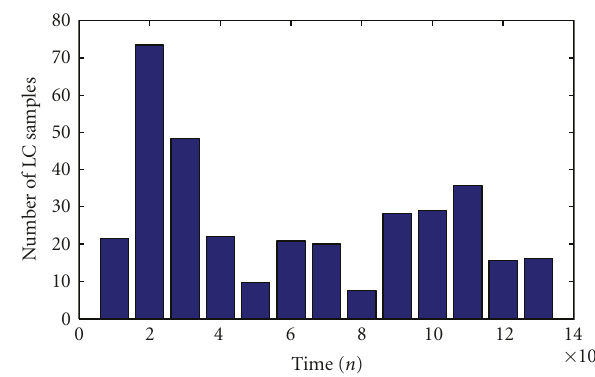
Figure 6: The number of LC samples obtained using